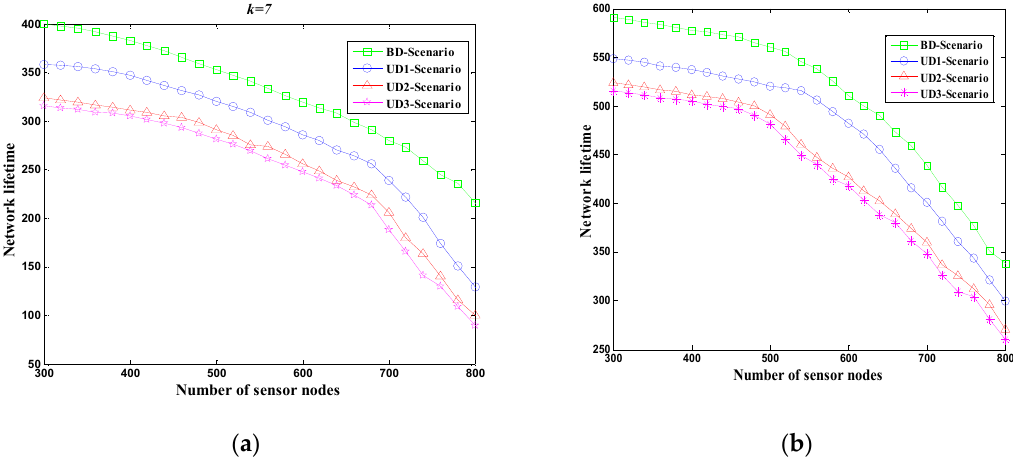
Figure 5. Network lifetime for four scenarios in different number of mobile sink. ( a ) k = 7; ( b ) k = 9.